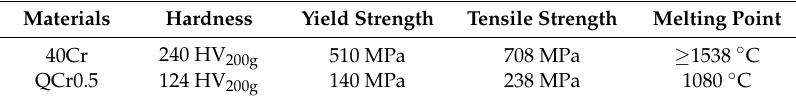
Table 2. Mechanical properties and melting points of 40Cr and QCr0.5.